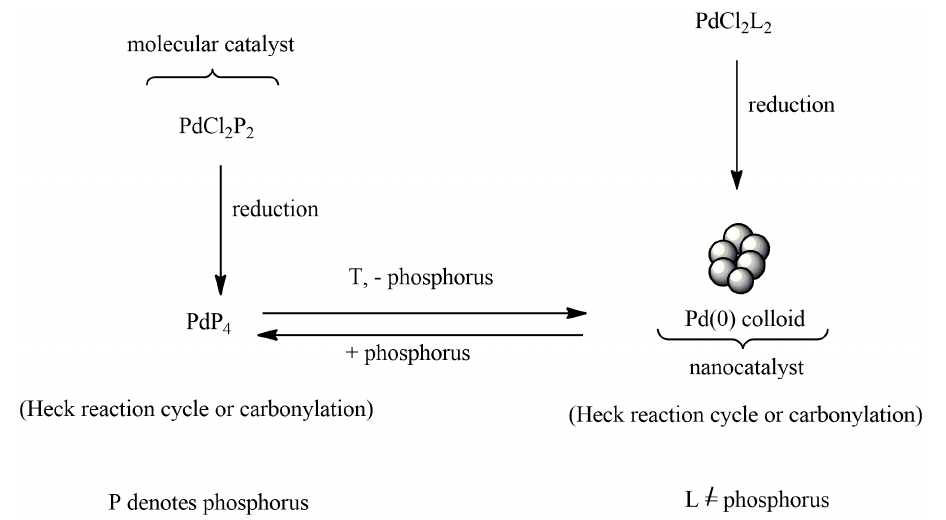
Figure 18. Transformations of palladium catalysts from monomolecular to nanoparticles. This figure is adapted from [129].